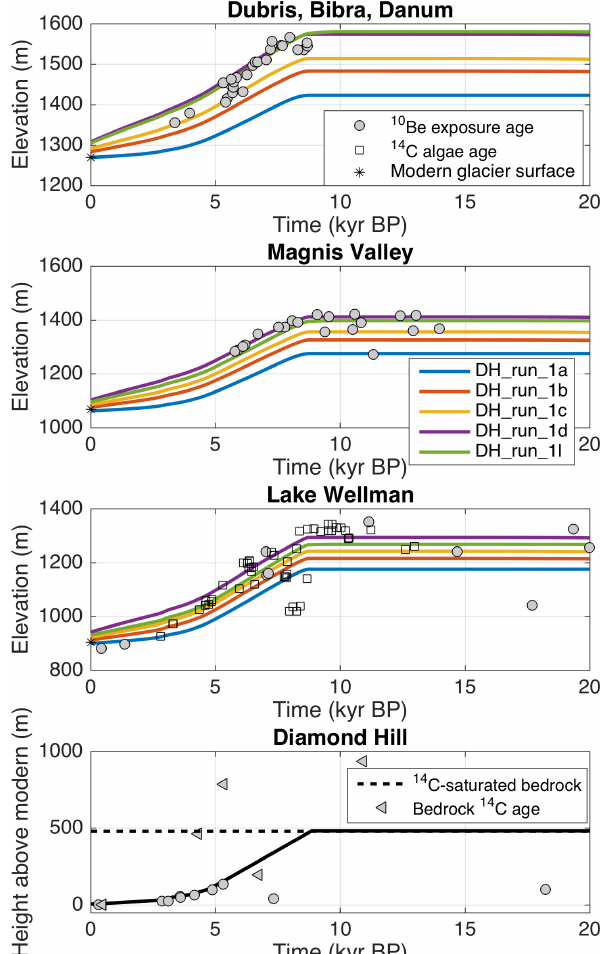
Figure 6. Flowband model results from Experiment 1 compared with surface exposure ages from this study and surface exposure and radiocarbon ages from King et al. (2020), which have been projected to centerline elevations using the method described in Sect. 3.1. The two best-fitting scenarios require either a larger catchment for both glaciers at the LGM (green curve; DH_run_1l) or an accumulation rate far higher than modern (purple curve; DH_run_1d). The black curve in the Diamond Hill panel represents the prescribed ice surface history at the downstream